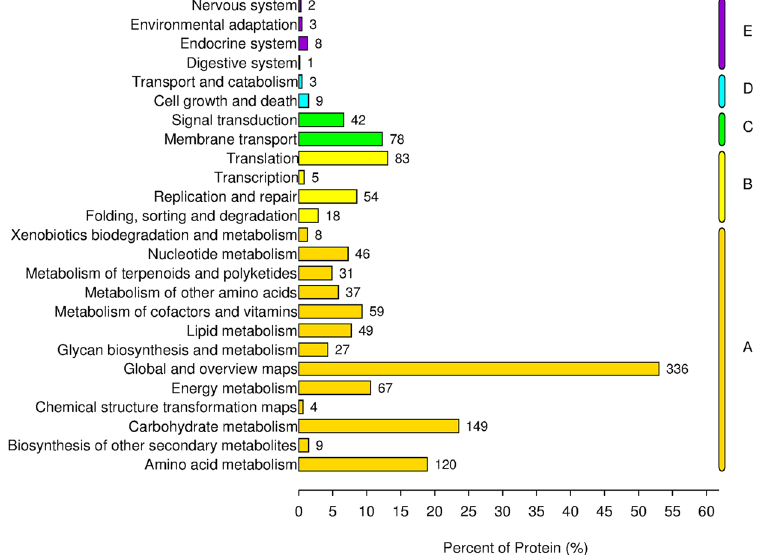
Figure 4. Related metabolomics pathways of overlapped proteins identified in two L . plantarum strains by KEGG classification. Each digital on the right of each bar indicates the number of proteins in each category. The letters A, B, C, D and E represent the 5 branches in KEGG pathways including Metabolism (A), Genetic Information Processing (B), Environmental Information Processing (C), Cellular Processes (D) and Organismal Systems